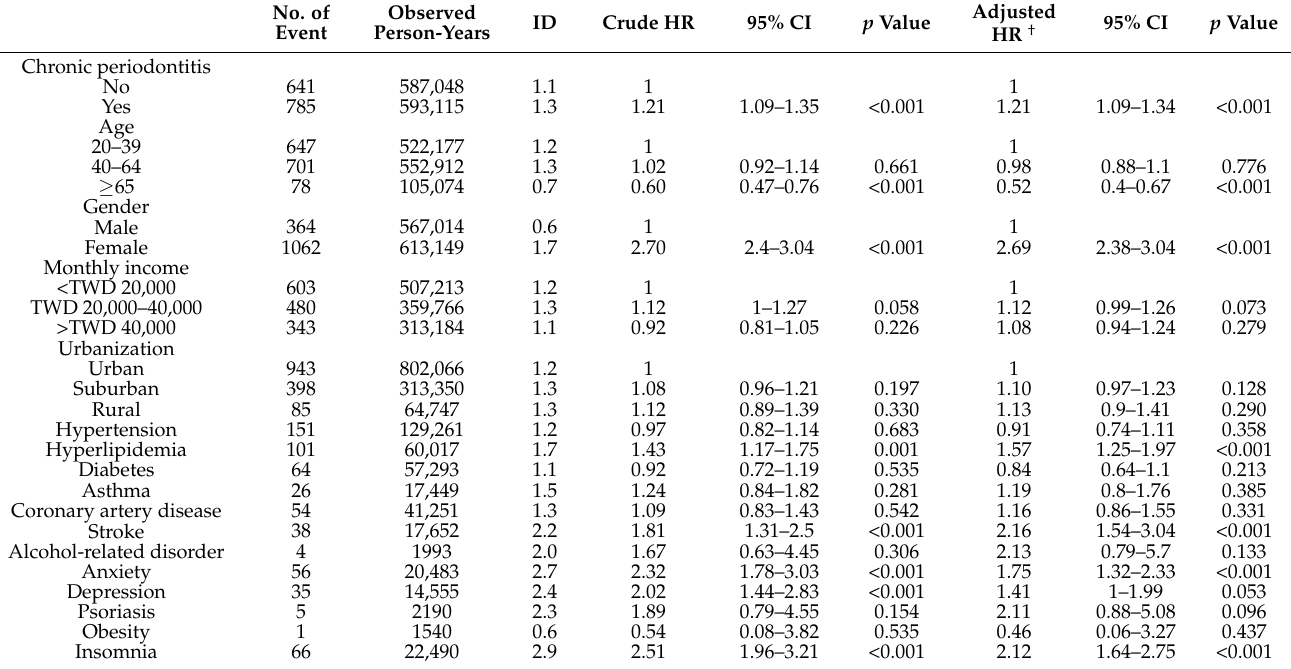
Table 2. Risk factor analysis of migraine